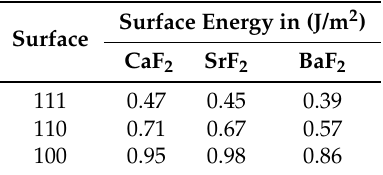
Table 2. PBE-calculated vacuum surface energies for the low-index surfaces of CaF 2 , SrF 2 and BaF 2